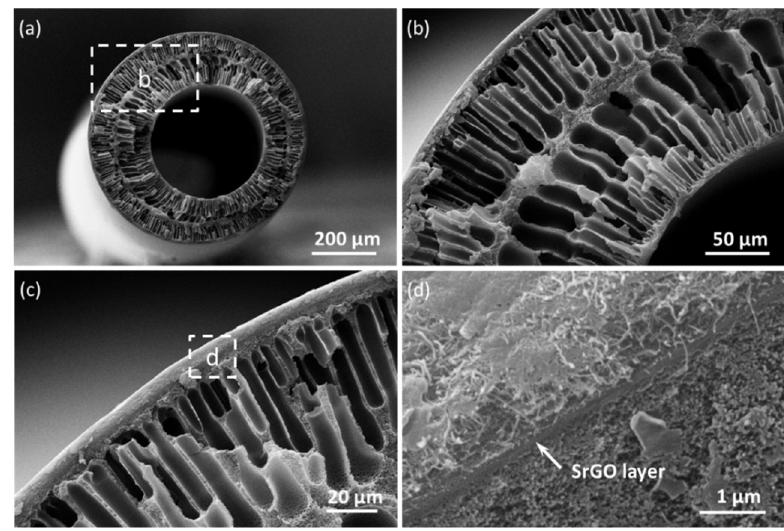
Figure 3. ( a ) Cross-sectional SEM images of the SrGO membranes; ( b ) Magnified area marked in a; ( c ) Magnified area marked in b; ( d ) Magnified area marked in c.